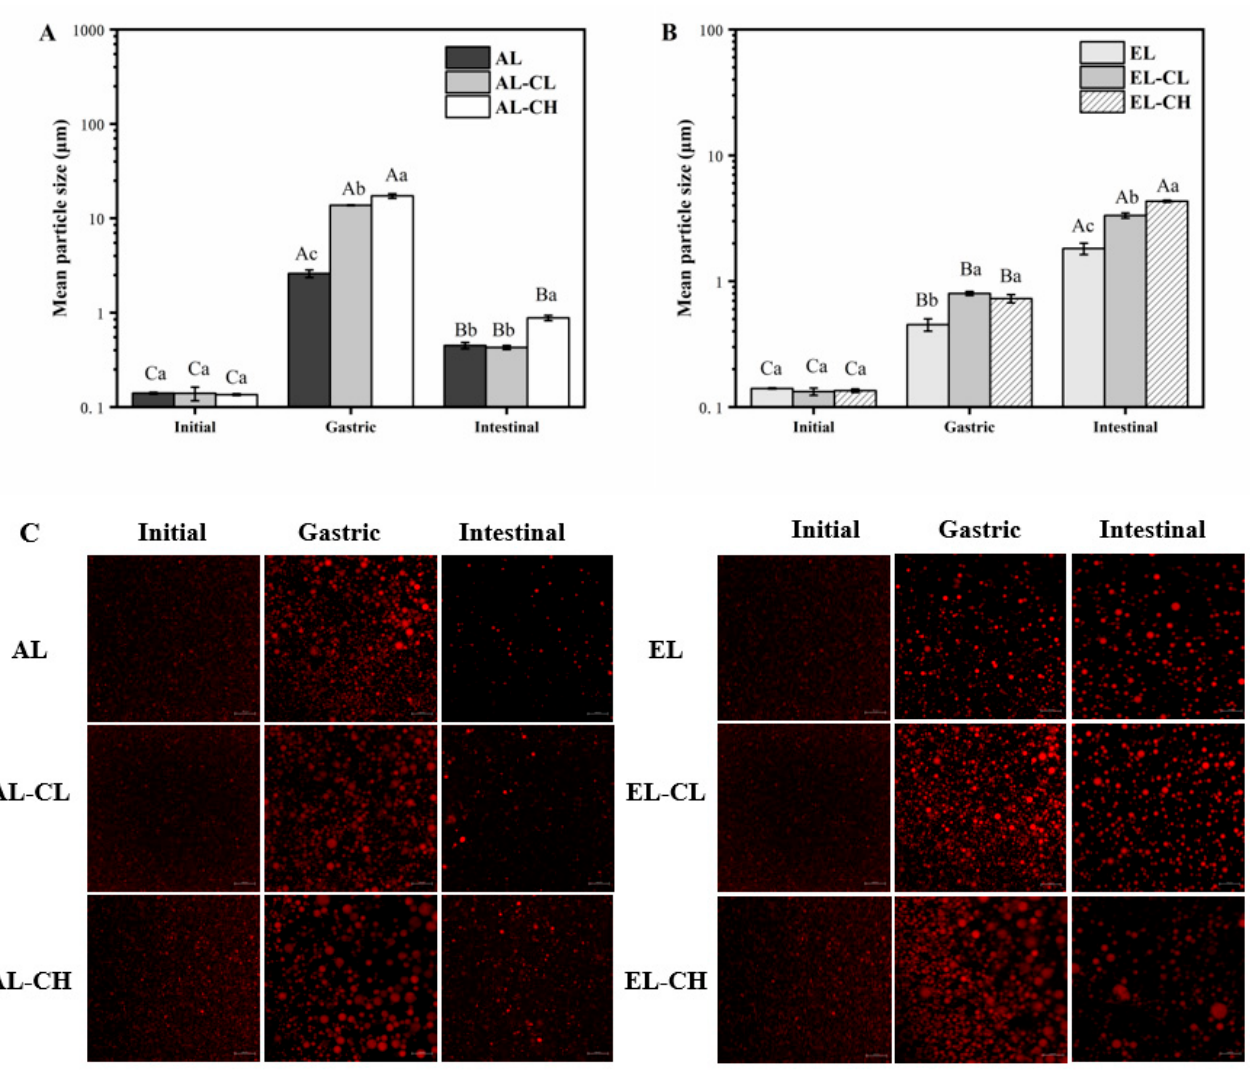
Figure 2. Mean particle size of initial emulsions and emulsions after different digestion stages of ( A ) adult and ( B ) infant and ( C ) microstructure images of emulsions after exposed to different digestion stages (scale bar of 10 μ m in all images). Data were shown as mean ± SD of three replicates. ( A – C ) Different capital letters indicated significant differences ( p < 0.05) in the same group (with same legend) at initial, gastric, and intestinal stages of digestion. a–c Different lowercase letters indicated significant differences ( p < 0.05) among different groups (with different legends) at the same stage of digestion. The same letter indicated no significant difference ( p > 0.05).